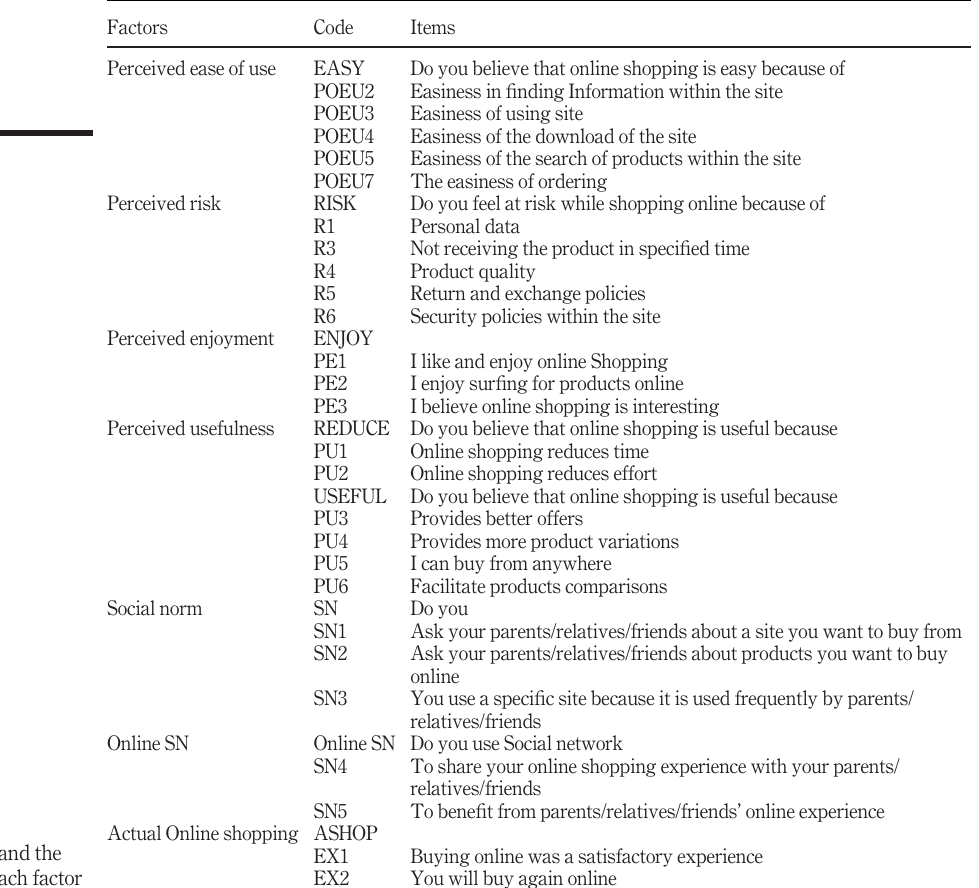
Table AI. The items and the codes for each